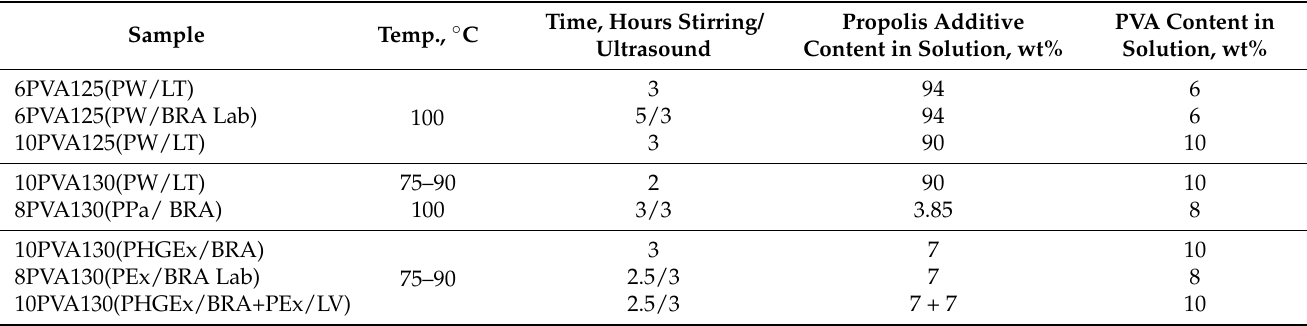
Table 9. Electrospinning solutions with propolis